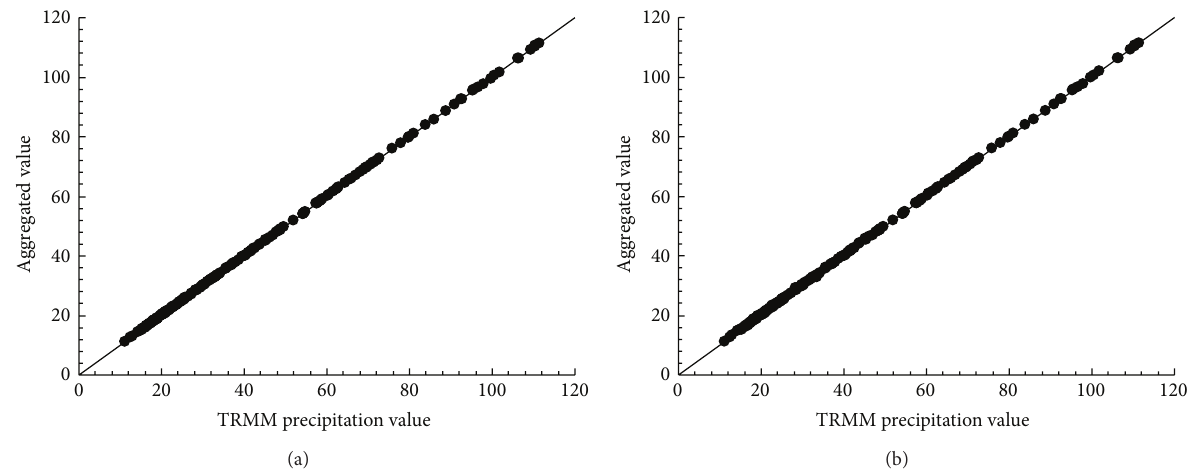
Figure 5: Scatterplots of the original TRMM precipitation values versus averages of area-to-point kriging estimates within each block: (a) downscaling without DEM and NDVI and (b) downscaling with DEM and